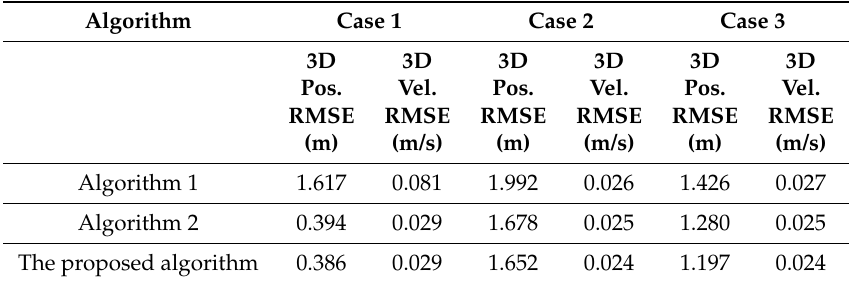
Table 1. Quantitative comparison of the robustness of the three